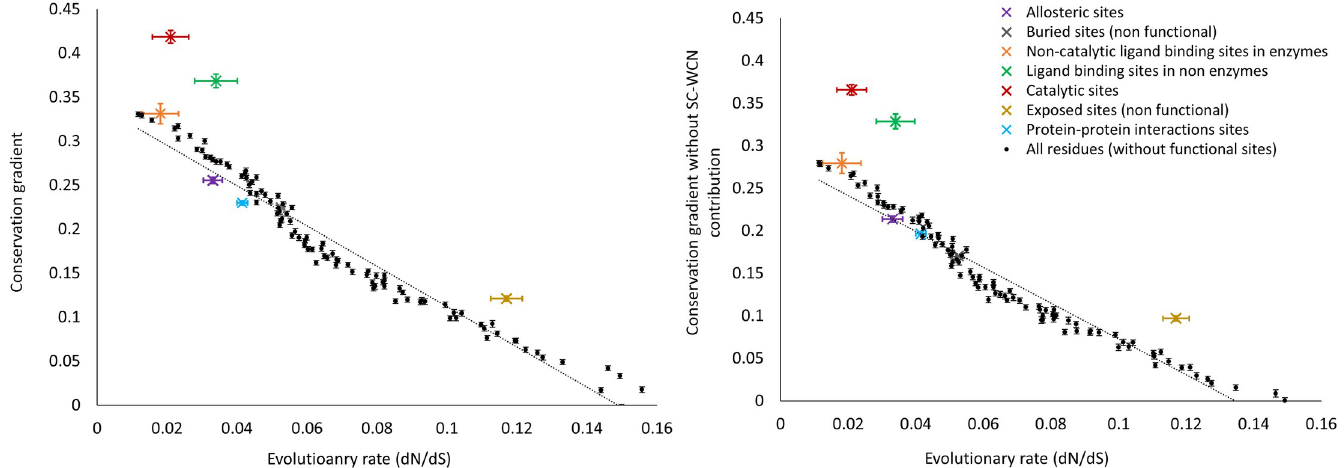
Fig 3. Conservation gradient induced from residues is linearly (negatively) correlated with their evolutionary rate (dN/dS), with catalytic site residues inducing stronger conservation gradient than expected by the linear trend. (A) Average conservation gradient (calculated as the average Pearson correlation between conservation of residues and their distance from a site) as a function of average evolutionary rate (dN/dS) for all yeast protein residues binned according to their annotated conservation rank into 100 equally spaced bins as well as the average conservation gradients of different types of functional sites. (B) Average conservation gradient without the relative contribution of SC-WCN as a function of average evolutionary rate (dN/dS) for all yeast protein residues binned according to their annotated conservation rank into 100 equally spaced bins as well as the average conservation gradients without the relative contribution of SC-WCN of different types of functional